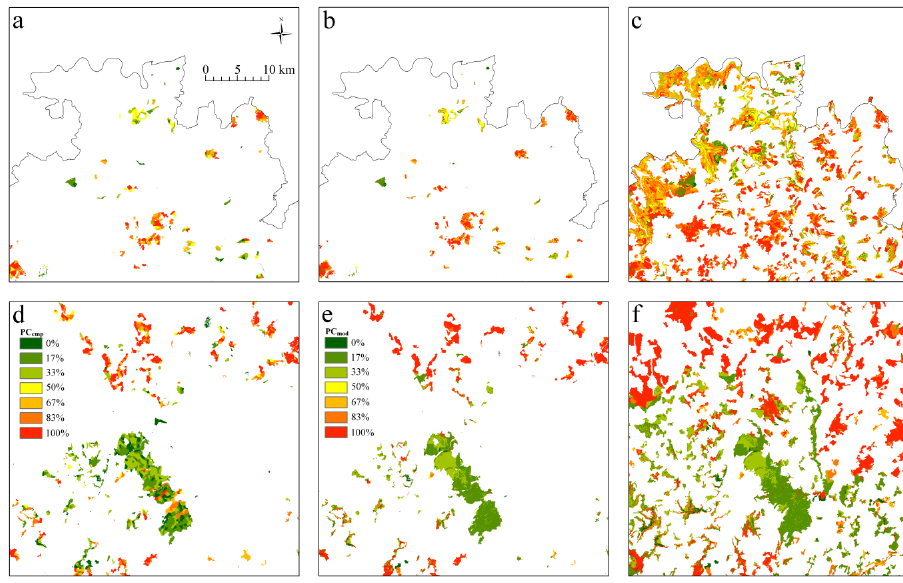
Figure 10. Two examples of ( a , d ) PC emp ; ( b , e ) PC mod for the state forest; ( c , f ) PC mod for all types of forest ownership in the presented map extract.